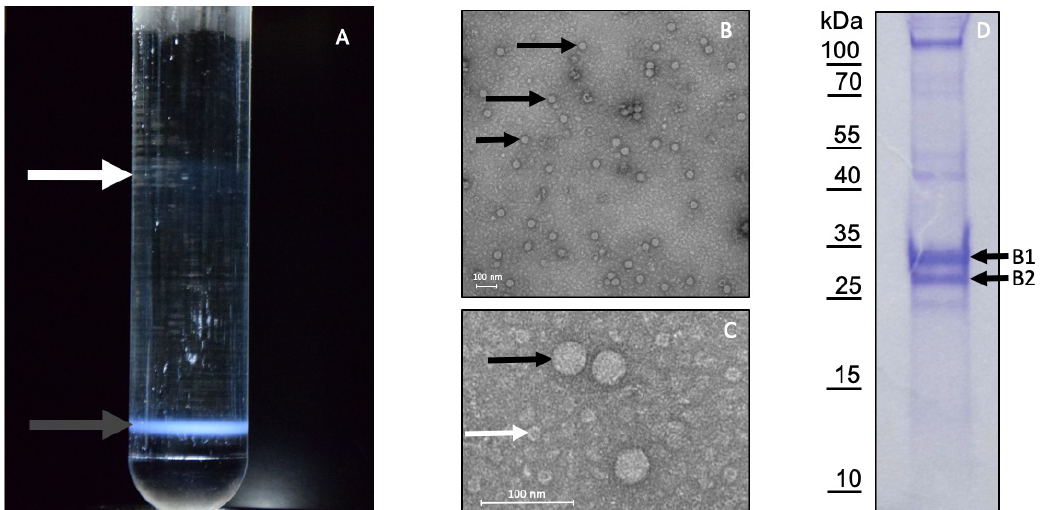
Figure 5. Purification and analysis of La Jolla virus (LJV) particles. ( A ) CsCl gradient purification. The white arrow indicates turbid band of RT-PCR negative material with a buoyant density of 1.15–1.20 g/mL. The black arrow indicates a sharp band of LJV virions with a buoyant density of 1.36 g/mL. ( B ) Transmission electron micrograph of purified LJV particles in negative contrast at a magnification of 85,000 × , with black arrows indicating icosahedral structures ~30 nm in diameter. ( C ) Transmission electron micrograph of purified LJV particles in negative contrast at a magnification of 140,000 × , with the black arrow indicating icosahedral structures ~30 nm in diameter and the white arrow indicating co-purified material, possibly virion fragments. ( D ) SDS-PAGE analysis of purified LJV particles stained with Coomassie Brilliant Blue. Two dominant protein bands are visible (B1 and B2). Molecular mass markers are shown on the left.